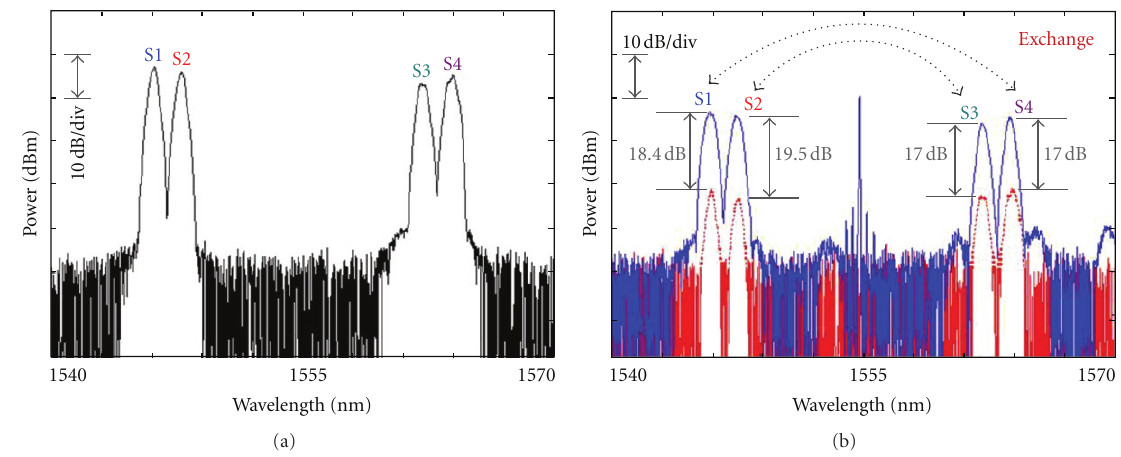
Figure 22: Spectra for four-channel DQPSK data exchange. (a) Input four-channel 100Gbit/s RZ-DQPSK signals. (b) Output spectra in the absence (dashed curve: Rayleigh scattering)/presence (solid curve: after data exchange) of CW pump.